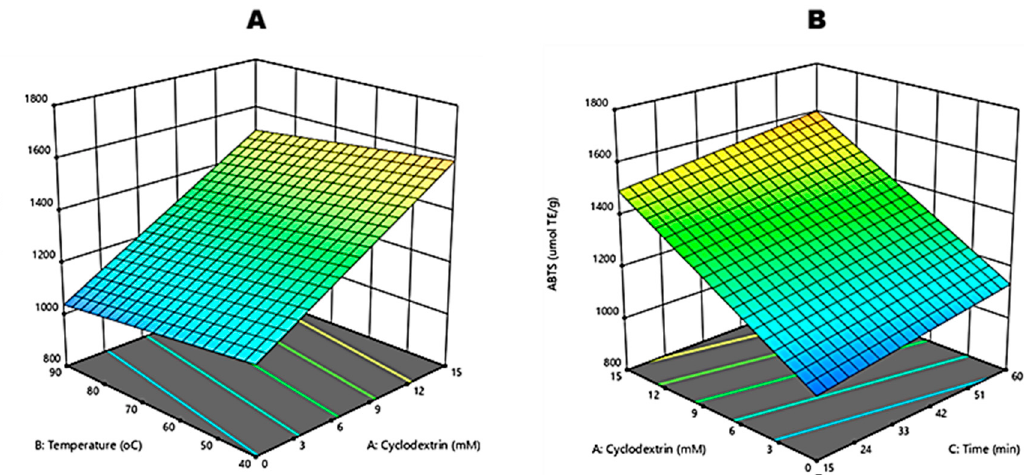
Figure 5. Response surface plots for independent variables for 2,2 ′ -azino-bis(3-ethylbenzothiazoline-6-sulfonic acid) (ABTS) radical scavenging of crude green rooibos extracts: ( A ) effect of Beta-cyclodextrin and reaction temperature and ( B ) effect of Beta-cyclodextrin and reaction time.